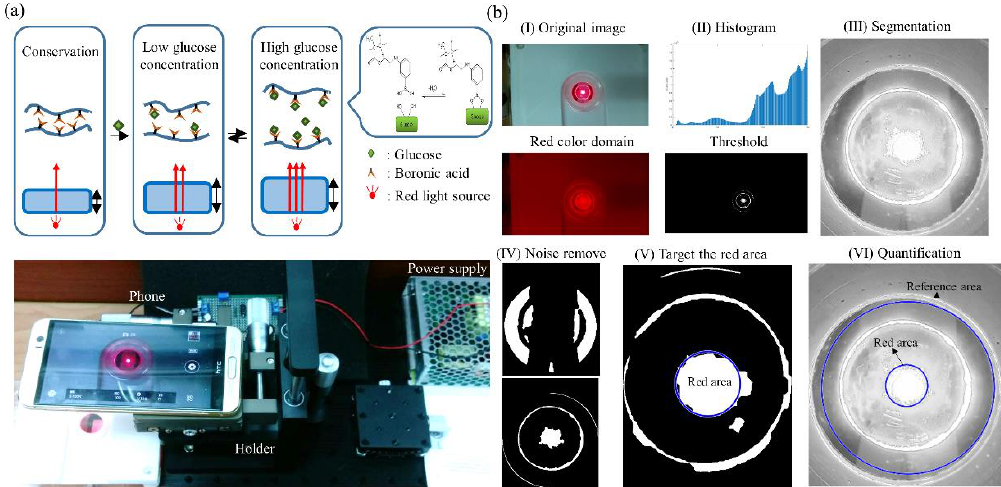
Figure 5. Automatic recognition of the thickness of the PBA-based HEMA contact lens glucose sensing using imaging processing. ( a ) Schematic of the PBA-based HEMA contact lens at different glucose levels. Different colors represent differences in the z-axis between the underside and surface of the contact lens (Top). Photograph of the platform with a smartphone used as the red-light source detection device (Down). ( b ) Photograph of the imaging processing: (I) Original image is segmented into three color domains, RGB converted to the gray level and the threshold to a binary image; (II) perform pre-segmentation on the area of interest and set the threshold; (III) find endpoints in the binary image and perform segmentation in the space domain for a morphologically close image; (IV) remove small objects from the binary image; (V) target the red light area and reference; (VI) measure the properties of the imaged regions and quantify the ratio of the red light area and reference.